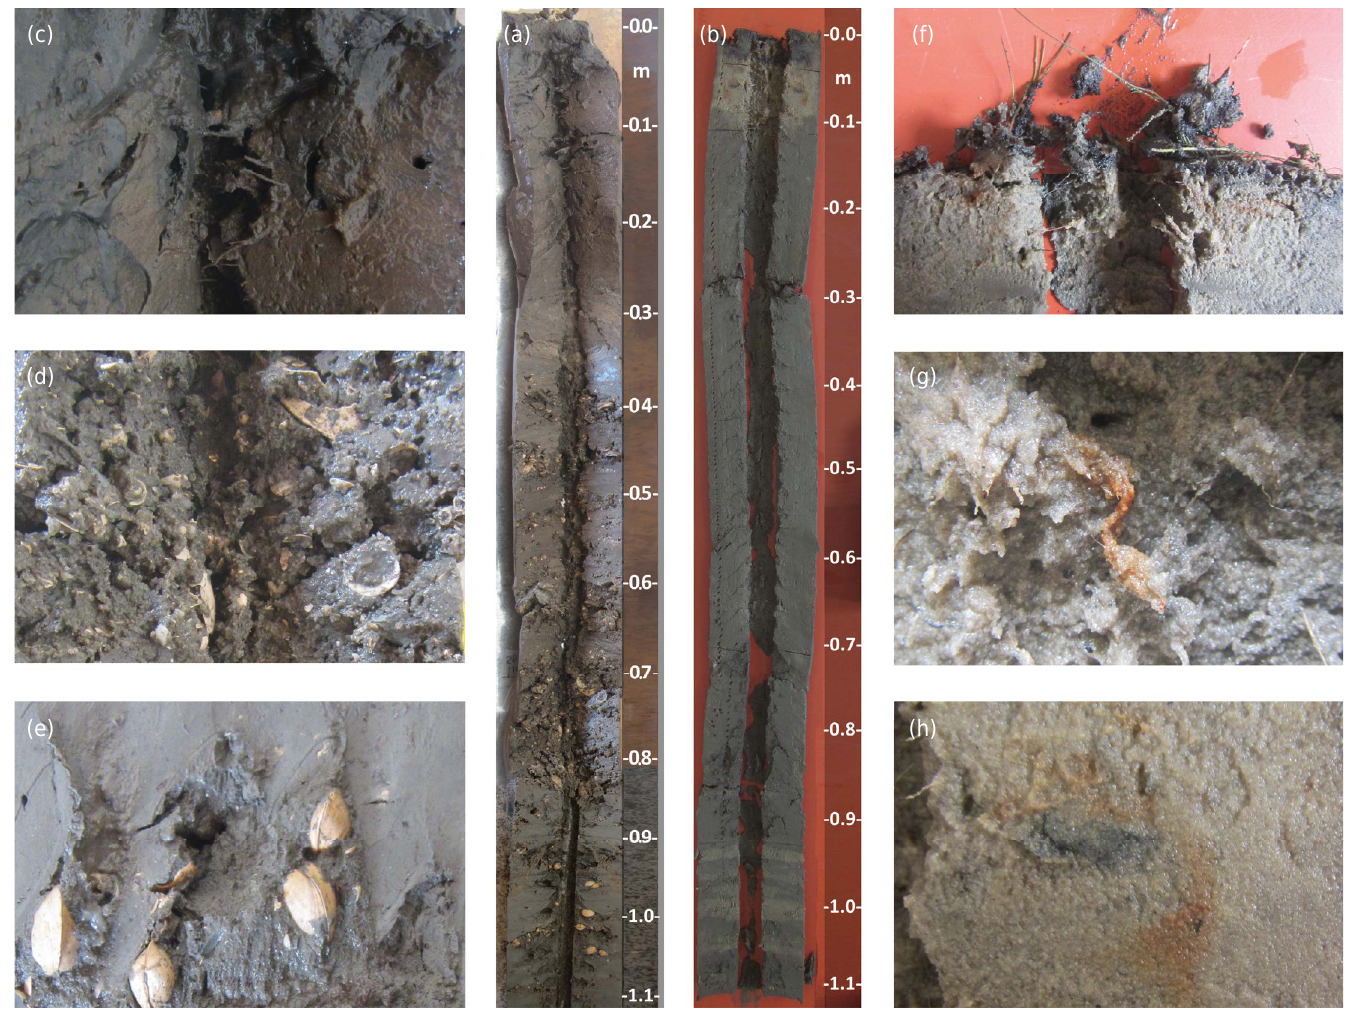
Figure 3. Subaqueous soil profile of the semiarid coast in the Northeast (a) and the Quaternary coast in the South of Brazil (b). In details, the variegated colors of the Agjz horizon (0.00-0.10 m) (c); broken seashells within a sandy texture matrix (2Cgjz horizon; 0.56-0.84 m) (d); whole seashells within a clayey matrix (horizon 3Cgjnz, 0.84-1.14 + m) (e), from the NE semiarid coast; surface soil horizon Agj (0.00-0.06 m) (f); mottles from sulfide production (black) and iron oxidation (brown) (ACgj horizon, 0.06-0.13 m) (g), and rhizospheric oxidation resulting in Fe oxyhydroxide precipitation (ACgj horizon, 0.06-0.13 m) (h) from the Quaternary coast in the